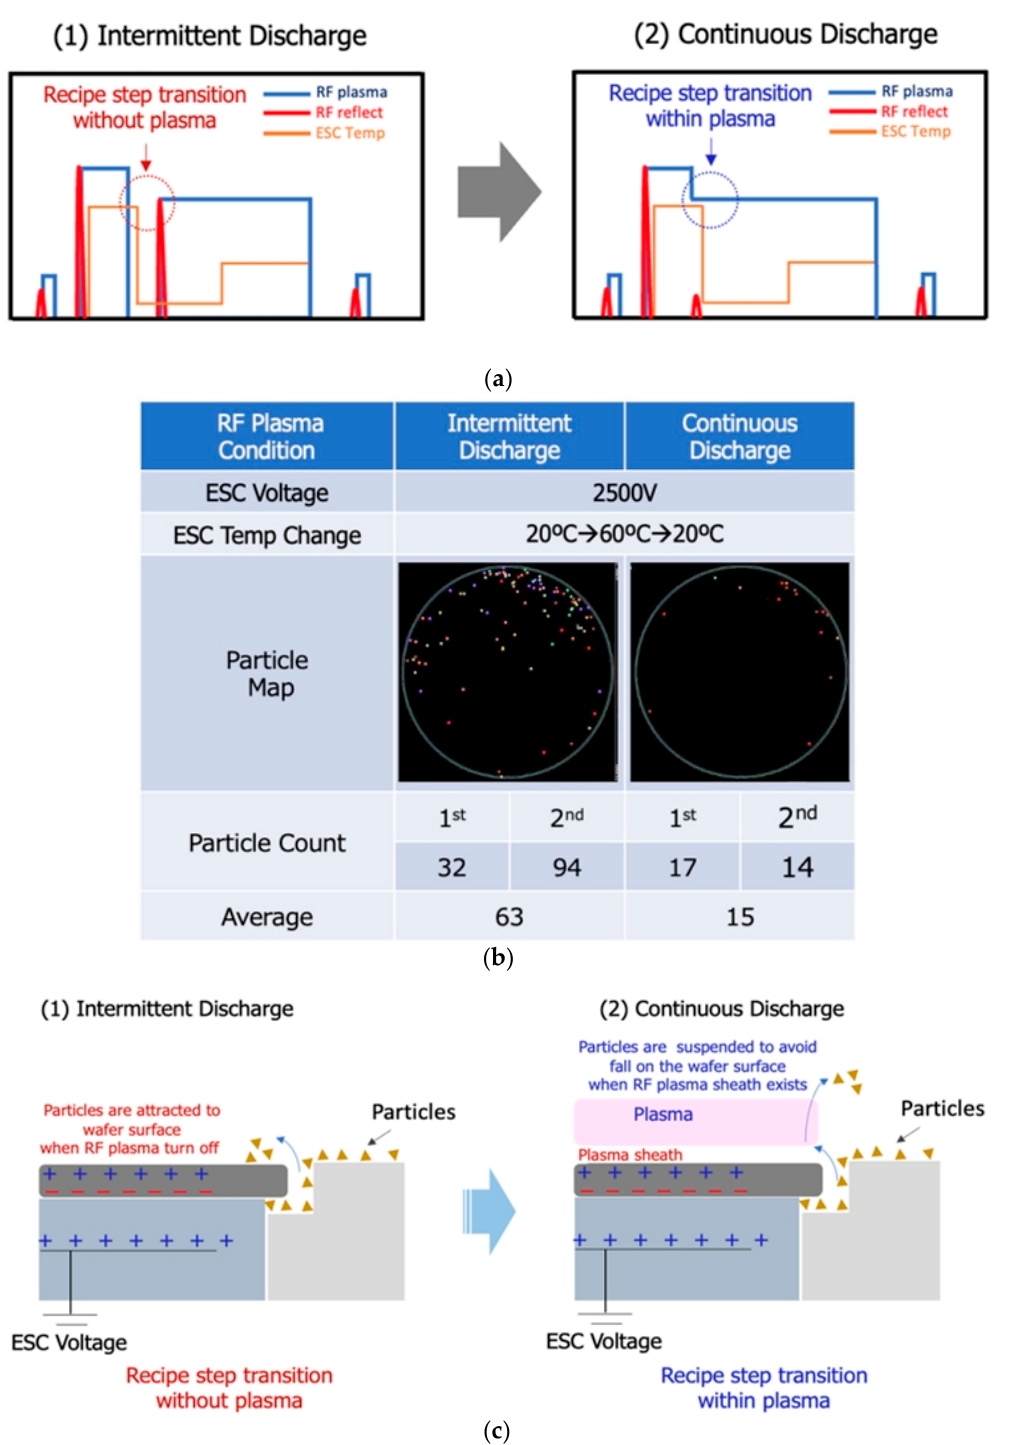
Figure 13. Distribution of particles under intermittent and continuous RF plasma discharges. ( a ) Graphs by intermittent and continuous radio-frequency (RF) plasma discharge. (1) The intermittent discharge sequence is a process recipe with no plasma during step transitions. (2) The continuous discharge sequence is a process recipe that keeps the plasma on during step transitions. ( b ) Particle counts under intermittent and continuous plasma discharge. ( c ) (1) Particles are attracted to the wafer surface because of the wafer potential. These particles originate from around related parts when recipe transition without plasma. (2) When the plasma flow is turn on, the plasma sheath prevents particles from being attracted to the wafer.